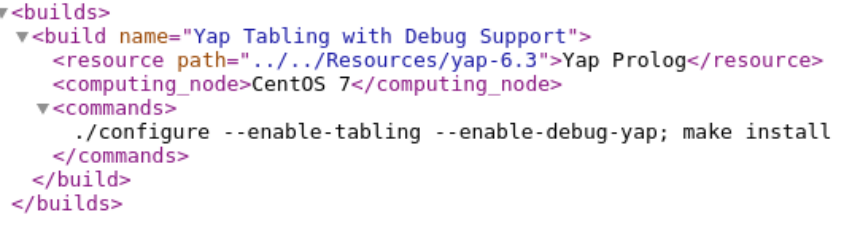
Figure 10. An example of the builds_list.xml